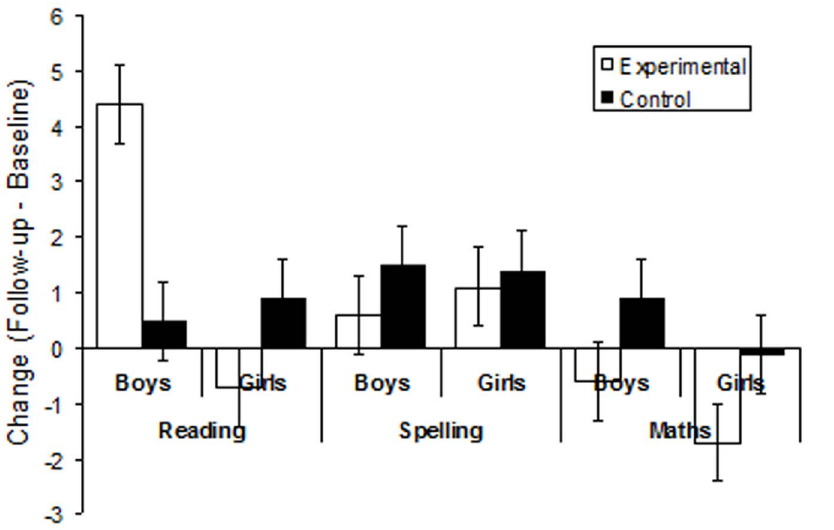
Figure 2. Mean in change (follow-up minus baseline) in BAS raw scores for the two groups (experimental = computer-based programme; control = normal reading classes) for both boys and girls.